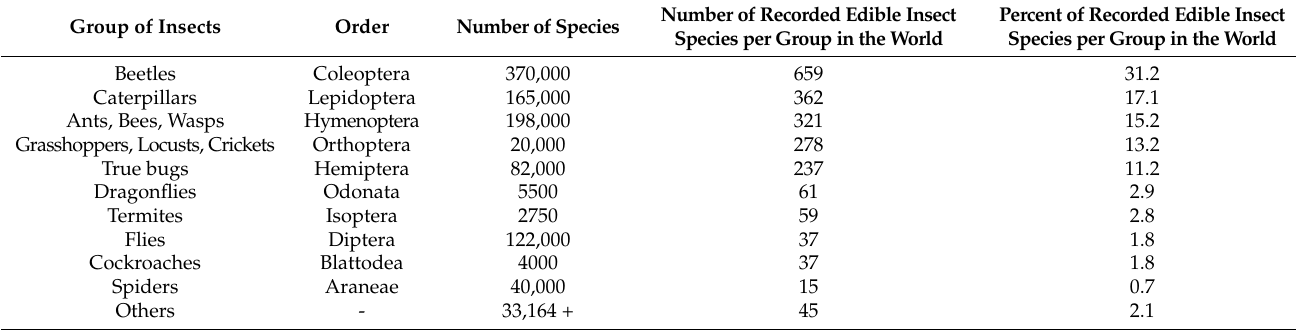
Table 1. Most commonly consumed insects around the world